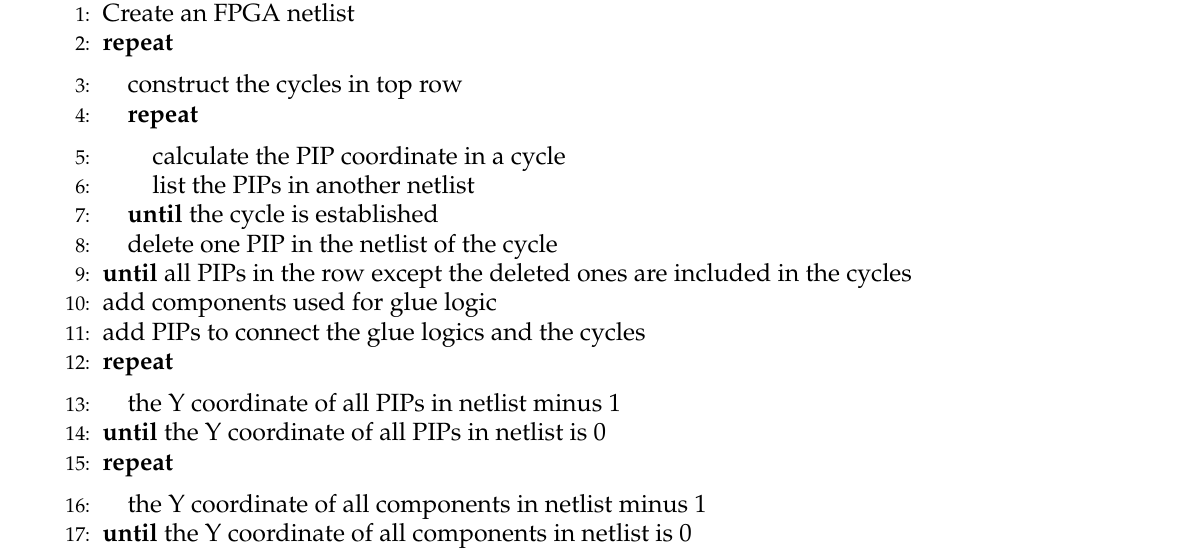
Algorithm 1 Automatic routing algorithm in the horizontal direction.